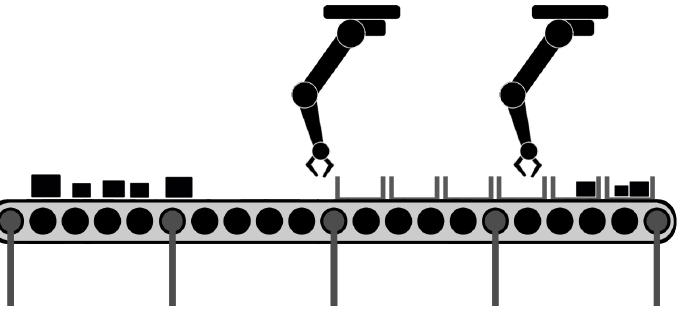
Figure 1. An illustration of a robotic arm batching